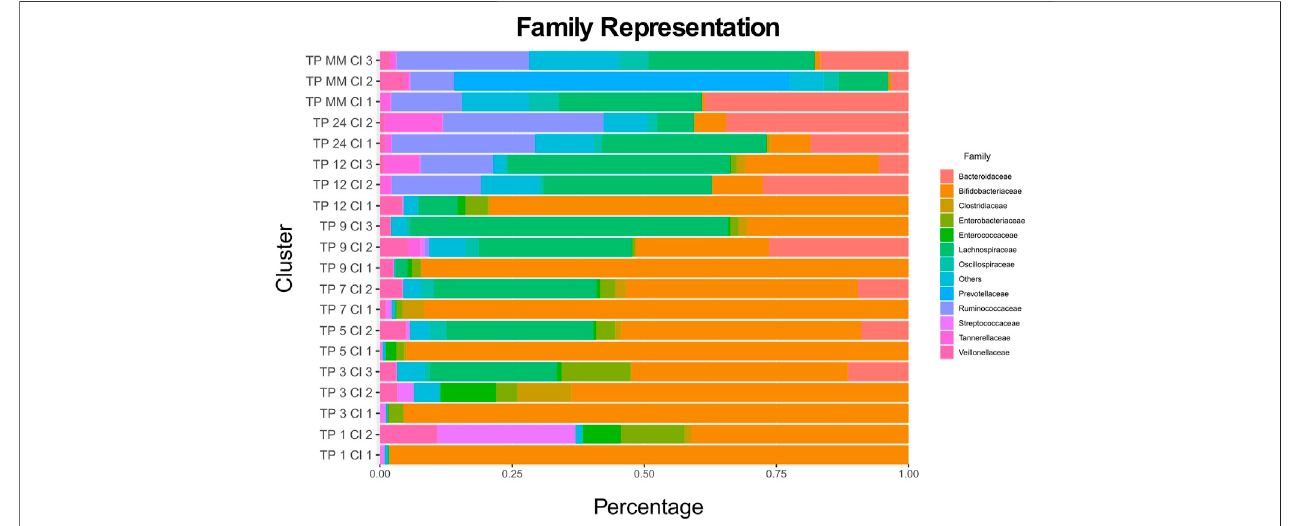
FIGURE5| Everyclustercompositionatafamilylevel.TPstandsfortimepointandClforthecluster.Familieswithanabundancelowerthan5%acrossallmedoids are cumulatively shown as